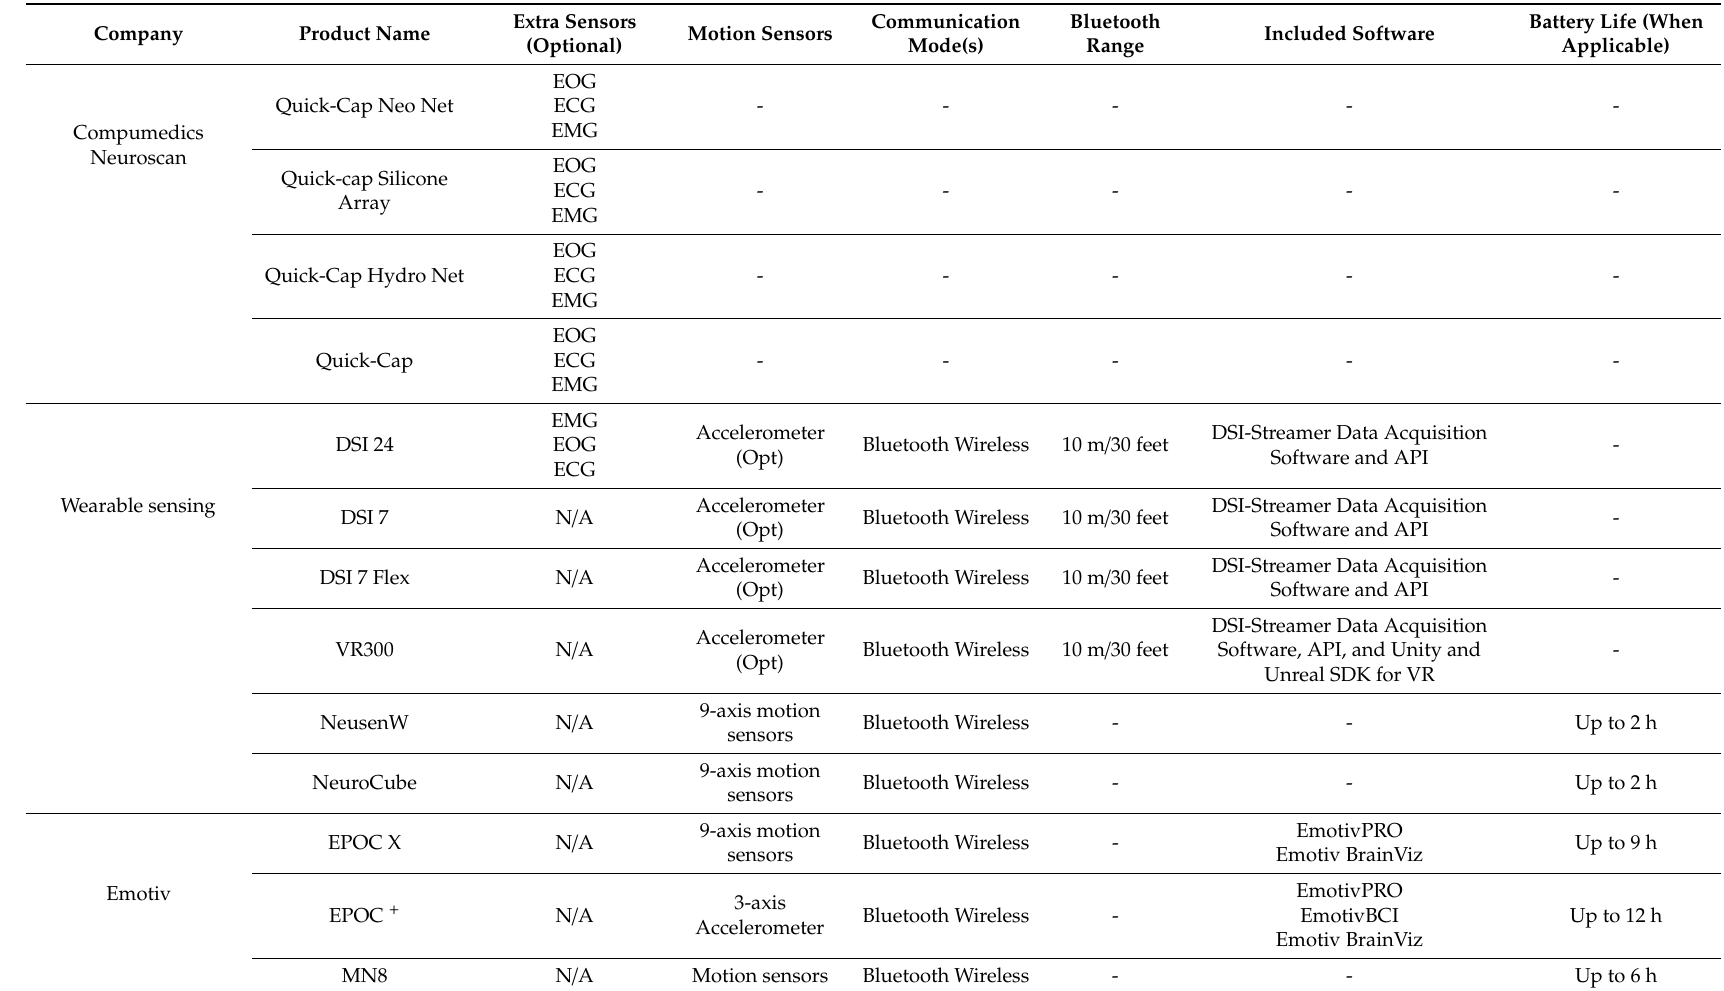
Table 2. Sensors